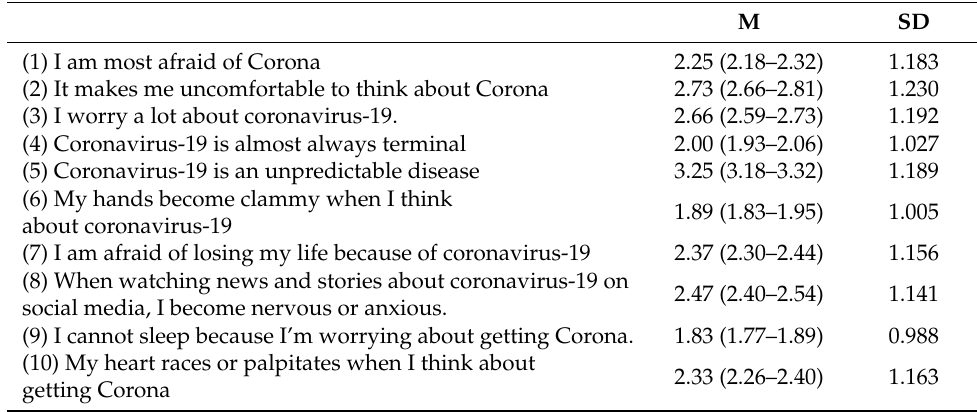
Table 2. Division of average item values